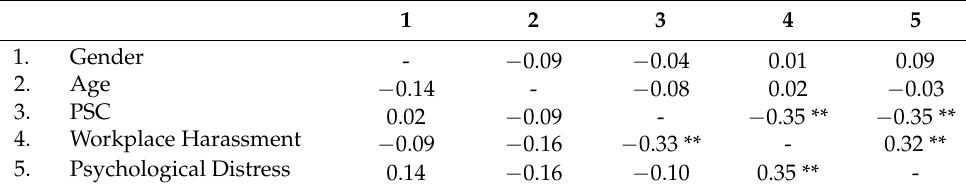
Table 1. Intercorrelations among variables.